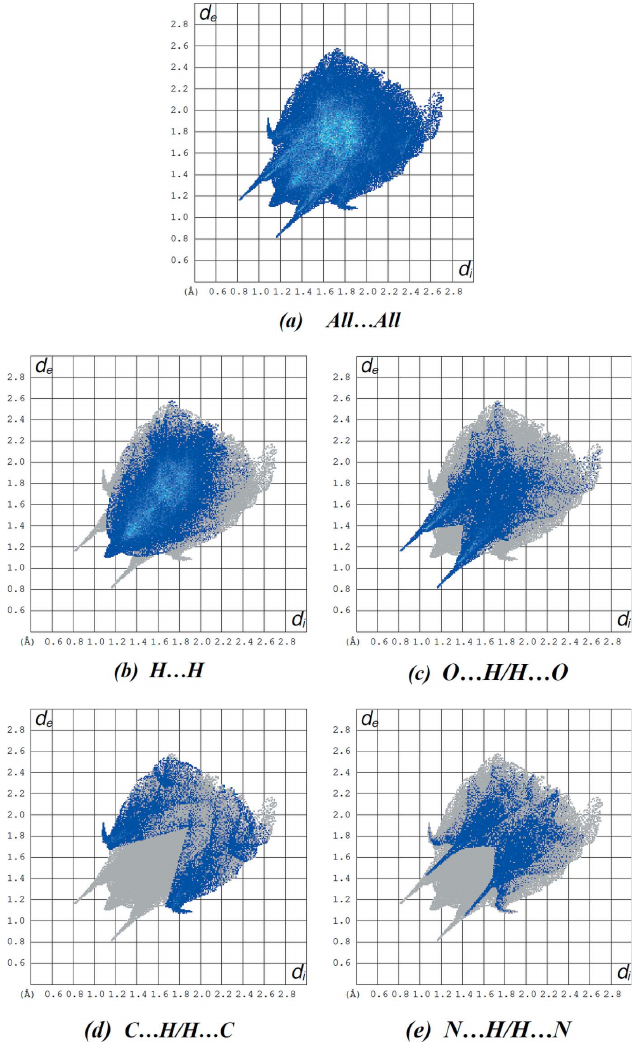
Figure 5 Two-dimensional fingerprint plots for the title compound, showing ( a ) all interactions, and delineated into ( b ) H (cid:2)(cid:2)(cid:2) H, ( c ) O (cid:2)(cid:2)(cid:2) H/H (cid:2)(cid:2)(cid:2) O, ( d ) C (cid:2)(cid:2)(cid:2) H/ H (cid:2)(cid:2)(cid:2) C and ( e ) N (cid:2)(cid:2)(cid:2) H/H (cid:2)(cid:2)(cid:2) N interactions. The d i and d e values are the closest internal and external distances (in A˚ ) from given points on the Hirshfeld surface.